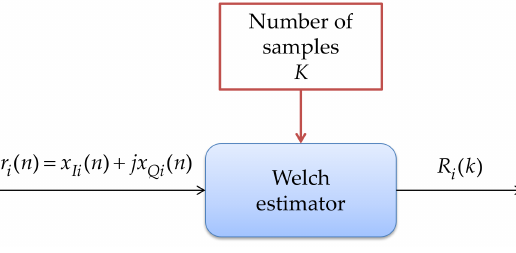
Figure 4. PSD estimation via the Welch method.